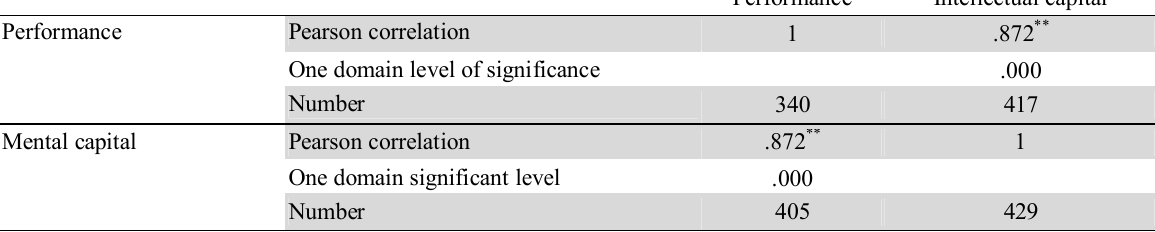
The summary of Pearson correlation